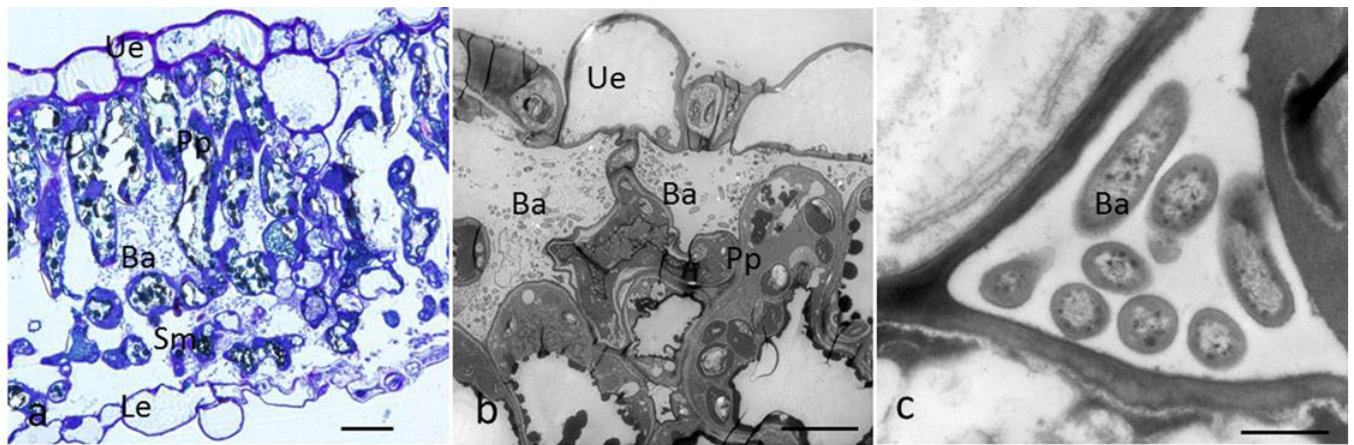
Fig 6. Light and transmission electron micrographs of a cross-section of kiwifruit leaf infected by the GFPuv-labeled Psa . (a), Intercellular bacteria in the mesophyll cells at 5 dai. Bar = 50 μ m; (b), bacterial colonization in the palisade parenchyma where the cells were abnormal. Bar = 10 μ m. (c), bacteria that have colonized the intercellular space. Bar = 1 μ m. Abbreviations: upper epidermis (Ue); palisade parenchyma (Pp); spongy mesophyll (Sm); lower epidermis (Le); bacteria (ba).